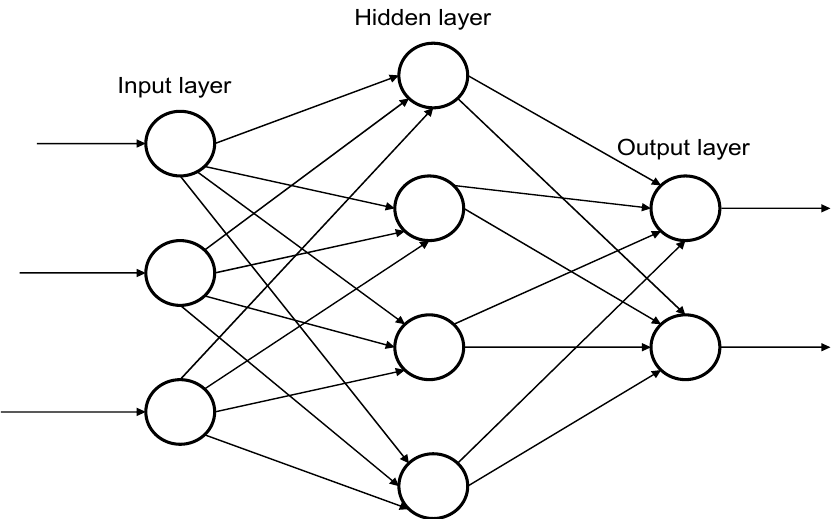
Figure 4. Neural network architecture.